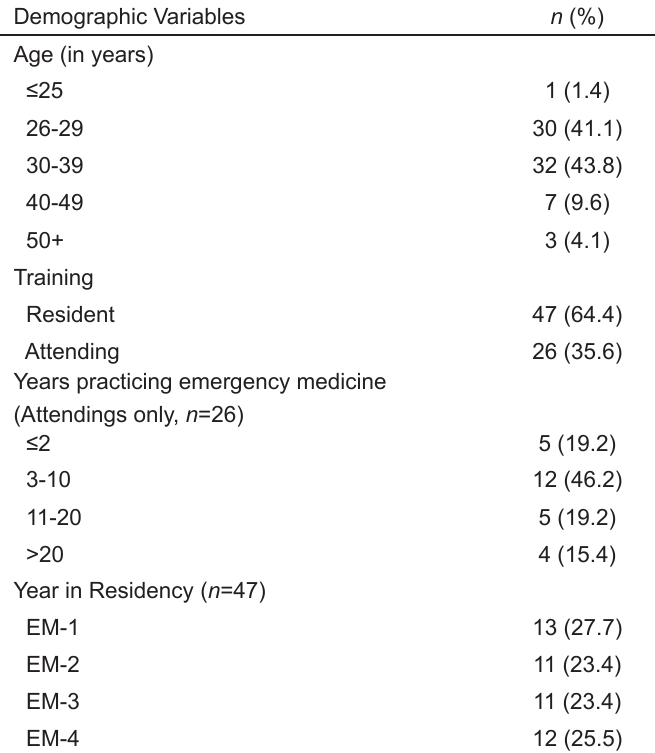
Table 1 . Demographics of emergency physician participants in survey about synthetic cannabinoid